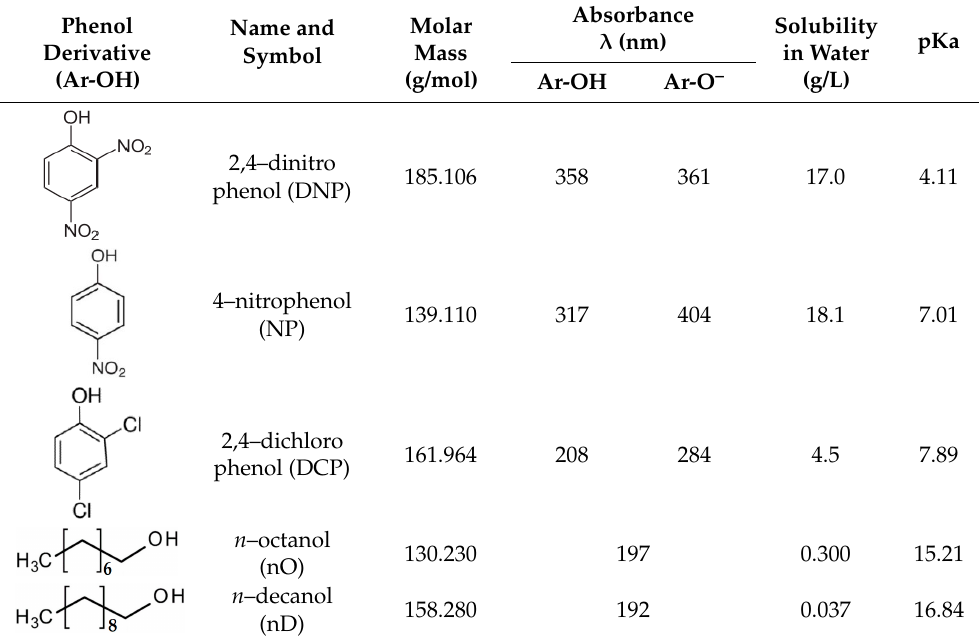
Table 1. The characteristics of the used organic compounds [31,32].